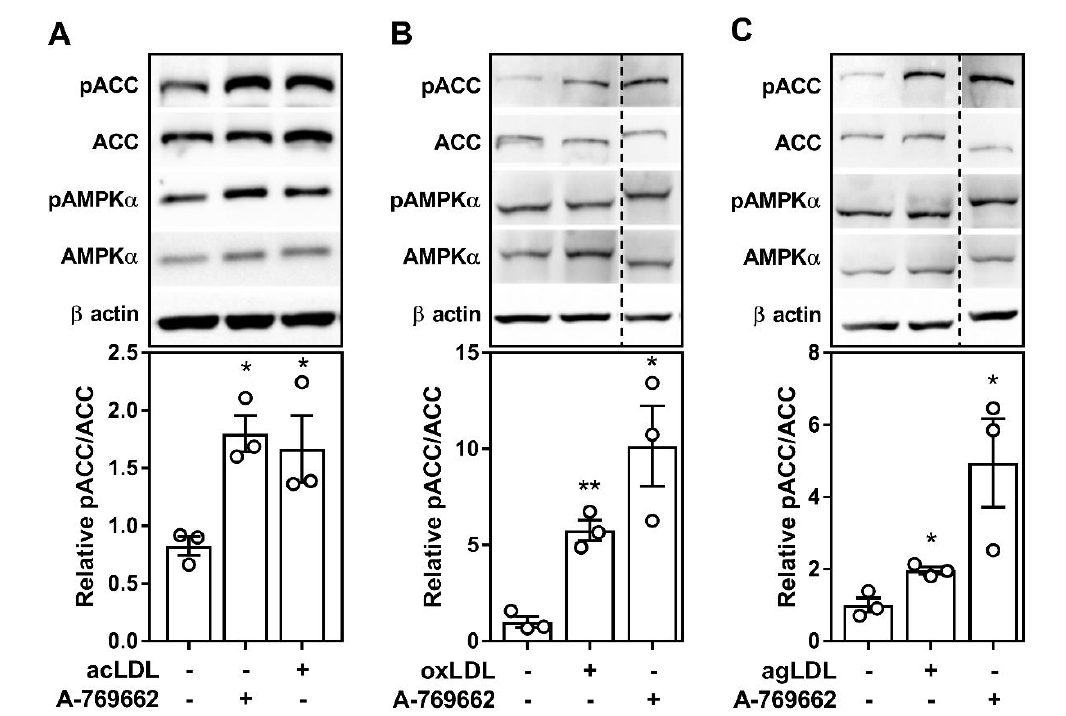
Figure 1. Atherogenic lipoproteins augment AMP-activated protein kinase (AMPK)-specific signaling in cultured macrophages. ( A – C ) Cells were isolated from wild-type (WT) mice, then incubated with either acetylated LDL ( A ; 50 µ g / mL), oxidized LDL ( B ; 50 µ g / mL), or aggregated LDL ( C ; 50 µ g / mL) for 24 h ( A ) and 18 h ( B , C ). Cells were incubated with A-769662 ( A – C ; 100 µ M) for 24 h ( A ) and 18 h ( B , C ) to serve as a positive control for AMPK activation. ( A – C ) Duplicate gels were used to assess total and phosphorylated proteins. Dashed line signifies where an image was cropped but represent the same gel. Phosphorylated acetyl Co-A carboxylase (ACC) / total ACC (260 kDa), pAMPK α / AMPK α (60 kDa), and β actin (37 kDa). Results are representative of three independent experiments and data represent the mean ± SEM, where * and ** represent a statistical di ff erence of p < 0.05 and p < 0.01, respectively, compared to vehicle control.